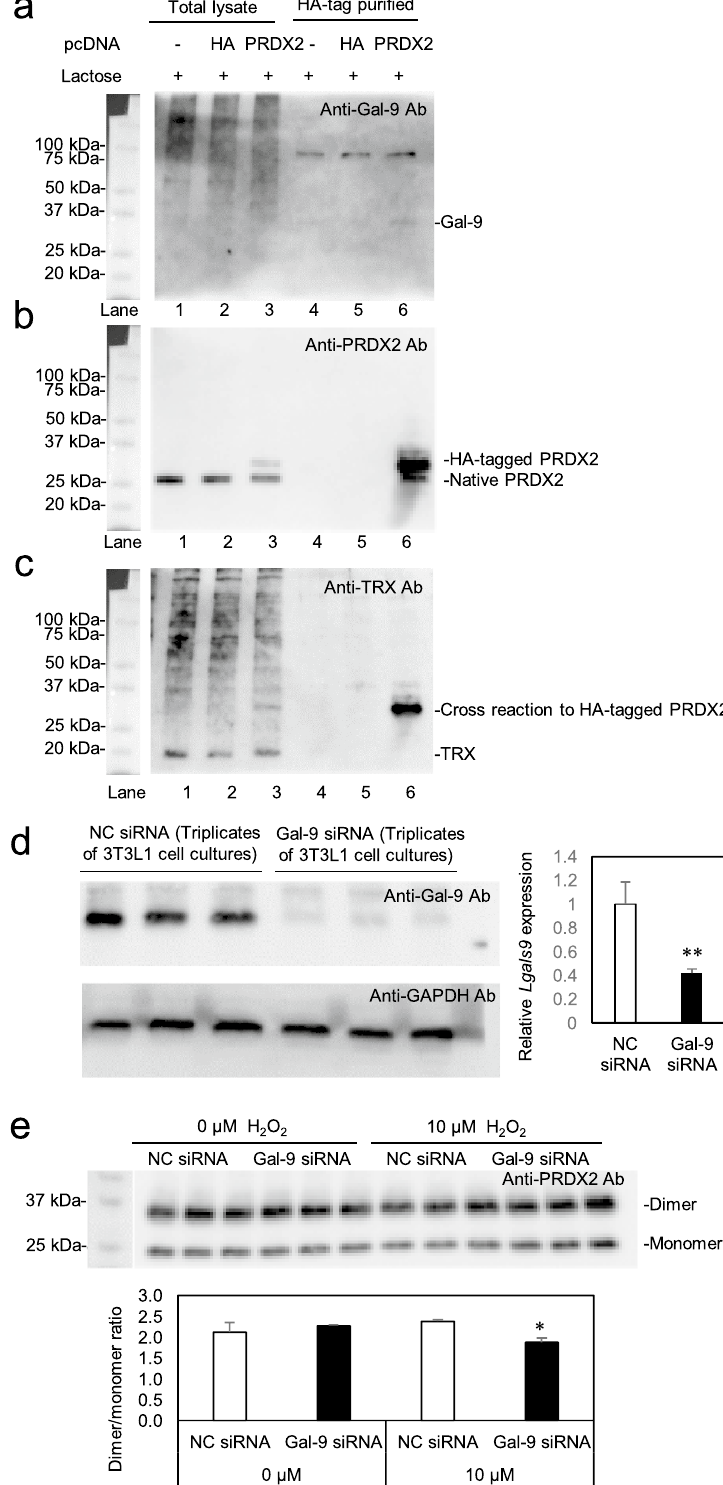
Figure 5. Pull-down assay and Gal-9 siRNA experiments in 3T3L1 cells. ( a ) PRDX2-FLAG-HA-pcDNA3.1 (PRDX2) and FLAG-HA-pcDNA3.1 (HA) were transfected into 3T3L1 cells. In the presence of 0.2 M lactose, the protein complexes were HA-tag purified with Anti-HA tag Beads, and subjected to SDS-PAGE under reducing conditions and Western blot analysis. The membrane was incubated with anti-Gal-9 antibody. ( b ) The membrane was stripped off and incubated with anti-peroxiredoxin 2 (PRDX2) antibody. ( c ) The membranes was again stripped off and incubated with anti-thioredoxin (TRX) antibody. ( d ) 3T3L1 cells were treated with Silencer select Pre-designed siRNA Lgals9 (Gal-9 siRNA) and Silencer select negative control siRNA (NC siRNA) for 40 h. ( e ) After the treatment of 3T3L1 cells with siRNAs, the cells were further cultured in the absence and presence of 10 μM H 2 O 2 for 20 min. *, p < 0.05; **, p < 0.01. Two-pair comparisons by Student’s t